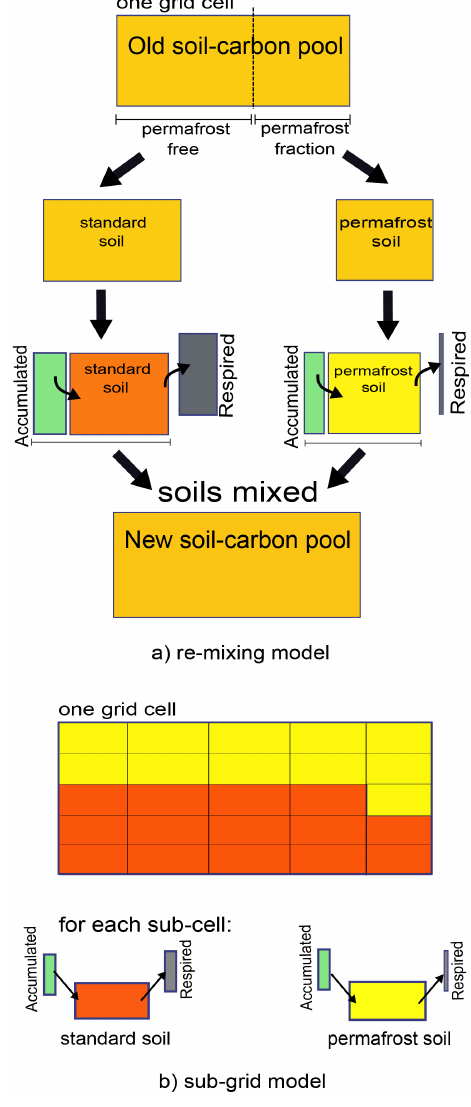
Figure 2. Schematic of a CLIMBER-2P grid cell showing how car- bon is accumulated at each time-step. Remixing model (a) separates grid cell into permafrost or non-permafrost, calculates the change in carbon pool and remixing all carbon in the cell back together. Sub- grid model (b) separates the grid cell into 25 sub-grid cells, calcu- lates change in carbon pool in each individually and does not remix any carbon between sub-grid